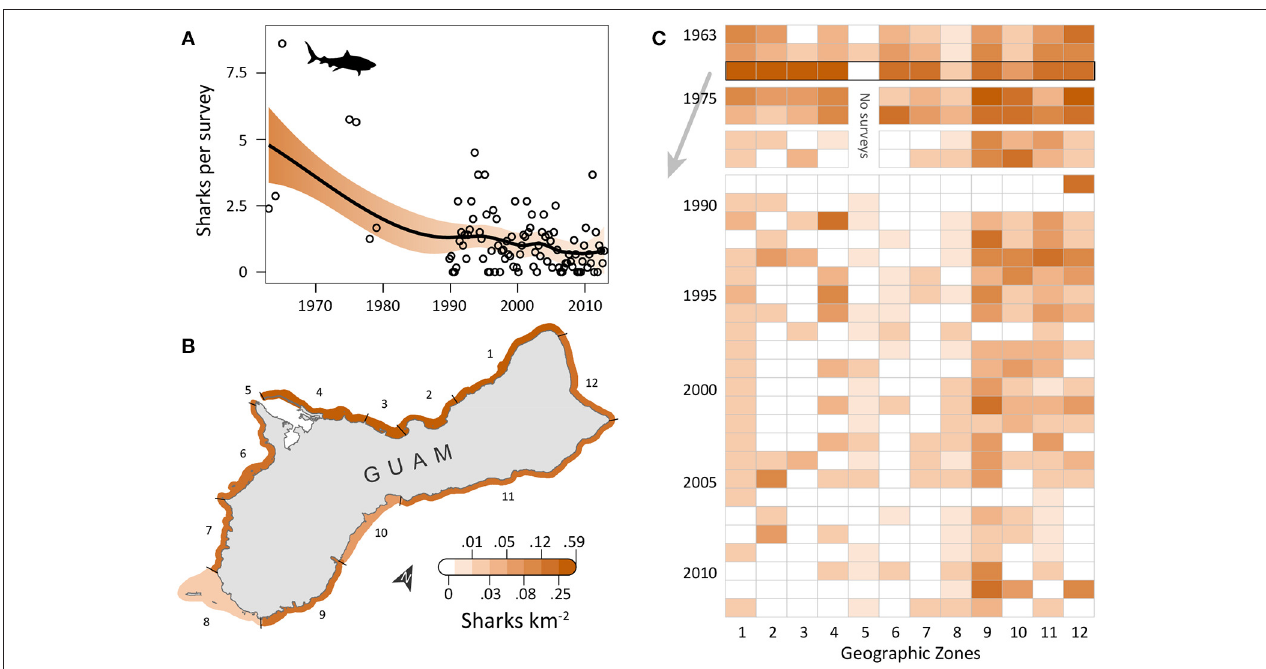
FIGURE 2 | Five-fold decline in reef shark observations around Guam in the last five decades. (A) Trend in shark observations from aerial surveys conducted semimonthly by Guam Division of Aquatic and Wildlife Resources (DAWR). Observations (sharks) per survey (OPS) by year or quarter are indicated by open circles. Smooth trend line and shaded 95% confidence interval are from a model fit. Since 1963, mean population growth rate (PGR) was − 0.03 ( SD = 0.04, CV = 138%). (B) Map of observed densities for 1965, when annual OPS was highest; densities were particularly high for western zones 1–4, especially compared to densities there in later years. (C) After 1976, west coast observations became sporadic and densities generally decreased. On the east coast (zones 9–11), densities were high through the 1990s, then decreased slightly, but remained generally higher than west coast densities. No surveys occurred in zone 5 in 1975–1979 due to military